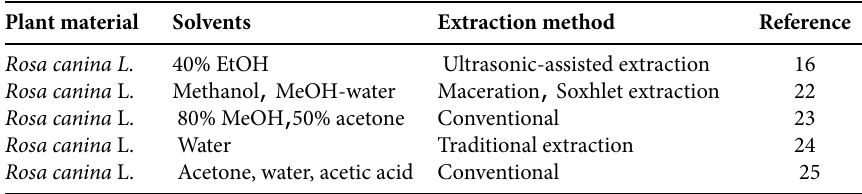
Table 2. Extraction of bioactive compounds from Rosa canina L. fruits reported in scientific literature Plant